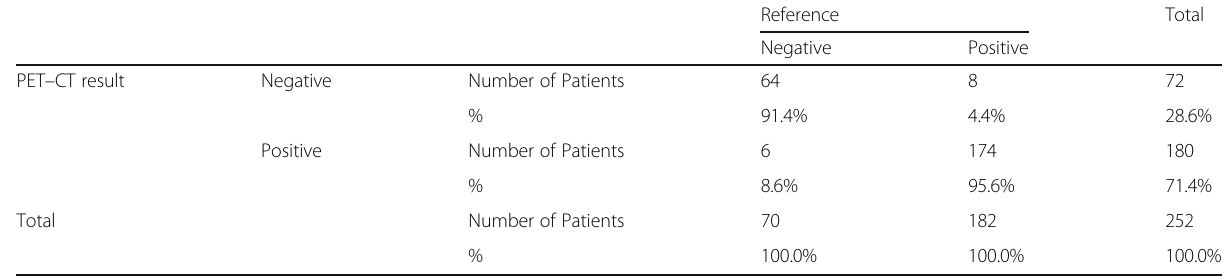
Table 3 Agreement of PET – CT with the reference modalities in detection of post-therapeutic colon cancer recurrence and metastasis (lesion-based analysis n = 252)